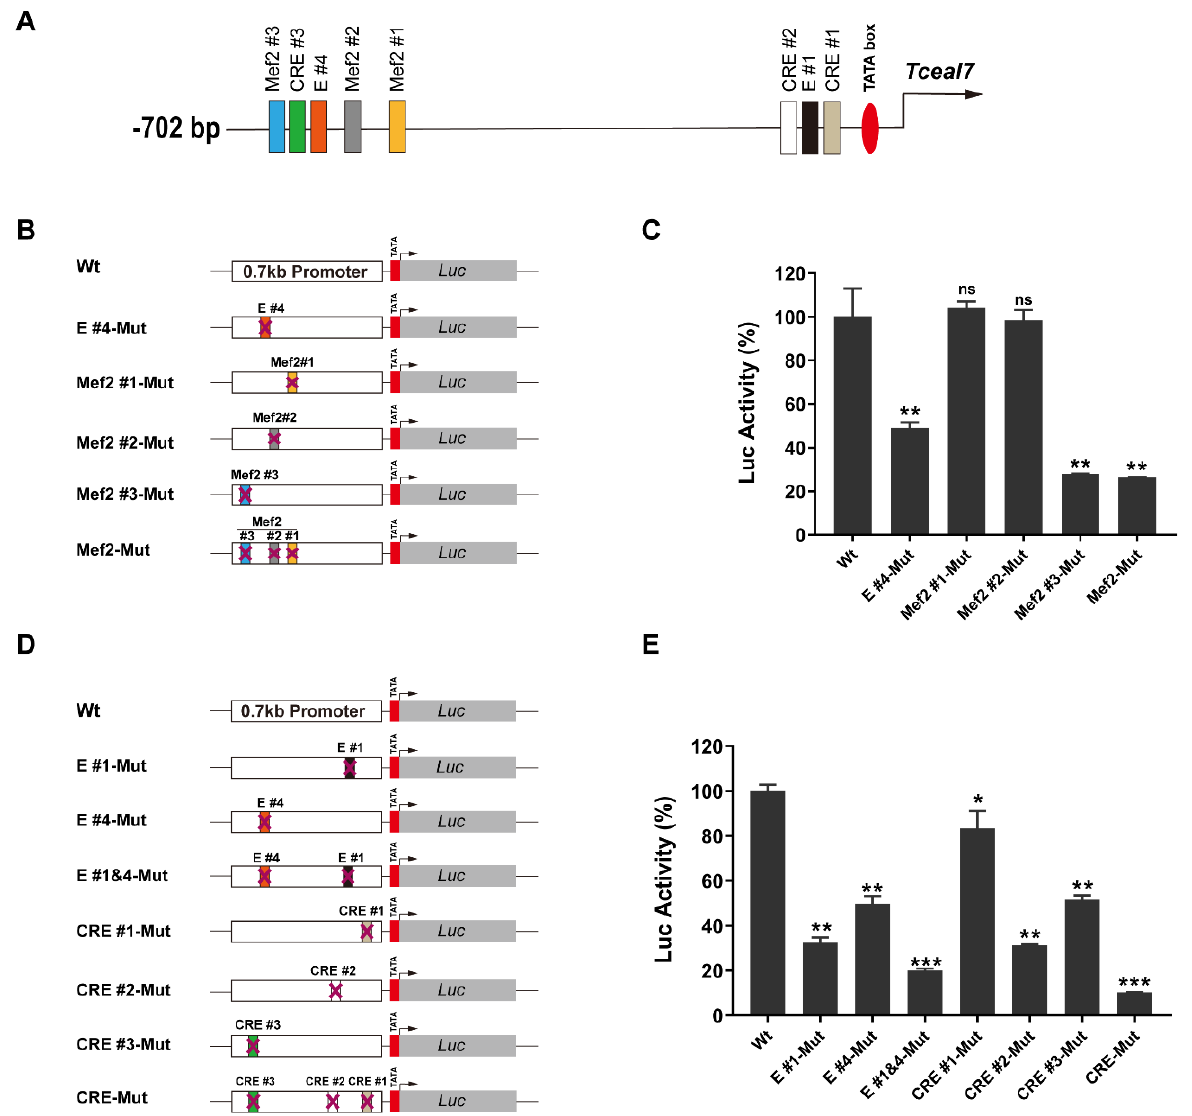
Figure 1. Functional role of Mef2 and CRE motifs in the Tceal7 promoter: ( A ) Schematic illustration of the distribution of transcription factor-binding motifs in the Tceal7 promoter. Three Mef2 motifs, three CRE motifs, two E-boxes and a TATA box are clustered into two regions: TATA box, CRE#1, E#1 and CRE#2 in the proximal region; Mef2#1, Mef2#2, E#4, CRE#3 and Mef2#3 in the distal region. ( B ) Schematic diagram of the luciferase reporter of the Tceal7 promoter containing the mutation of the E#4 or Mef2 motif. Wt, wild-type reporter; Mef2#1-Mut, Mef2#1-mutant; Mef2#2-Mut, Mef2#2- mutant; Mef2 #3-Mut, Mef2#3-mutant; Mef2-Mut, mutation of Mef2#1, #2 and #3 motifs. ( C ) Mutation of Mef2#3 instead of Mef2#1 or Mef2#2 results in a decrease in the promoter activity (28% of that of the wild-type reporter) in the C2C12 myotubes. Additional mutation of Mef2#1 and Mef2#2 does not further reduce the promoter activity. Mutation of E#4 motif is utilized as an internal control. ( D ) Schematic diagram of the luciferase reporter of the Tceal7 promoter harboring E-box or CRE motif mutation. CRE-Mut, mutation of CRE#1, #2 and #3 motifs; E#1&4-Mut, mutation of E#1 and E#4 motifs. ( E ) Each individual CRE motif mutant is accompanied by decreased activity in the C2C12 myotubes: CRE #1-Mut, 83%; CRE #2-Mut, 31%; and CRE #3-Mut, 52%. The promoter activity of CRE-Mut is further downregulated to 10% with an E-box mutant reporter as the reference. All Data represent the mean ± SD of three independent replicates. * p < 0.05; ** p < 0.01; *** p < 0.001; ns, not significant. The comparisons are analyzed between the Wt group and the Mut